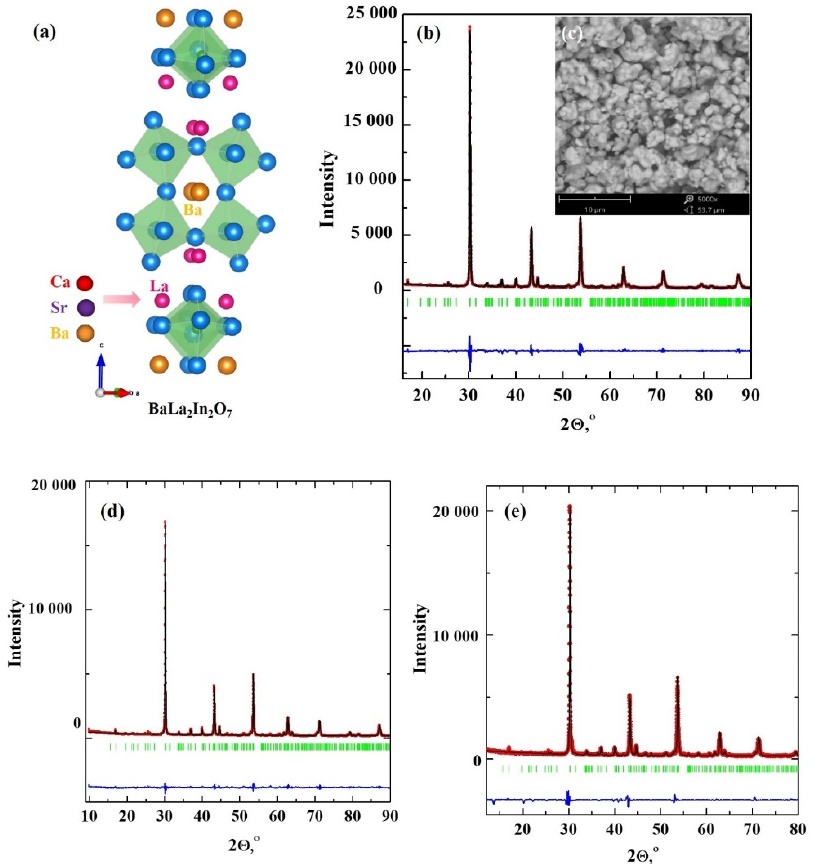
Figure 1. The scheme of acceptor doping of BaLa 2 In 2 O 7 ( a ), XRD-data ( b ) and SEM-image ( c ) for the composition BaLa 1.9 Sr 0.1 In 2 O 6.95 , XRD-data for the compositions BaLa 1.9 Ba 0.1 In 2 O 6.95 ( d ) and BaLa 1.9 Ca 0.1 In 2 O 6.95 ( e